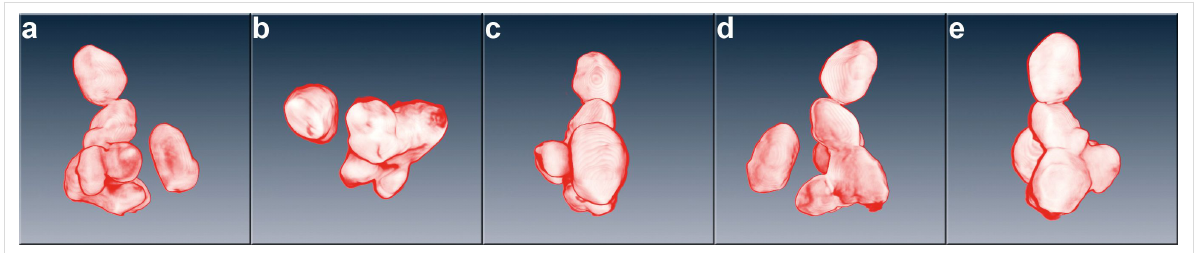
Figure 1: Schematic view of five different projections of one agglomerate found in KRONOS 2360, reproduced from an electron tomogram. The images (a) through (e) demonstrate that the projected area of the pigments varies greatly, depending on viewing direction. Moreover, they